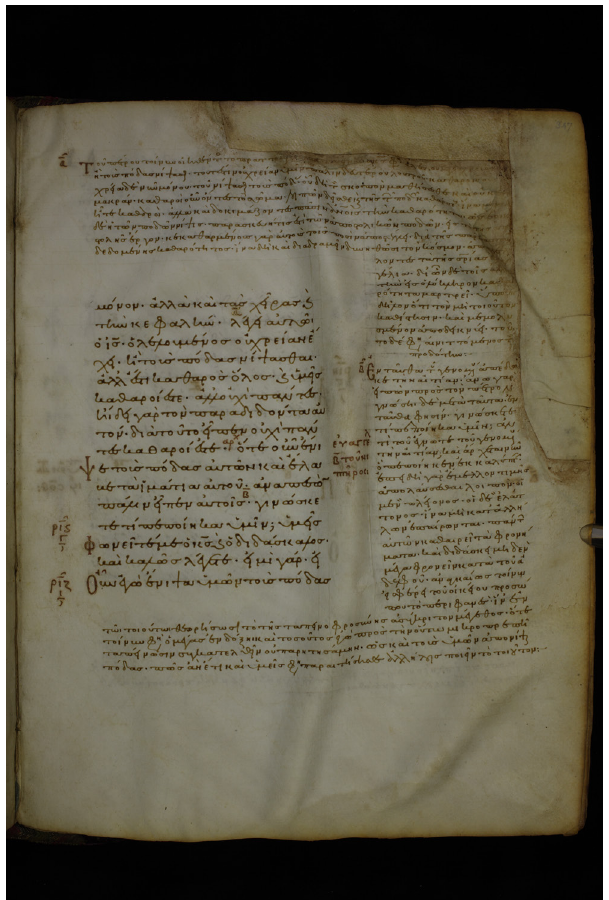
Figure 6 . GA 2604 (CBL W 139) 347r in CSNTM Library The Center for the Study of New Testament Manuscripts (www.csntm.org) digitized CBL W 139 at The Chester Beatty. © The Trustees of the Chester Beatty Library,